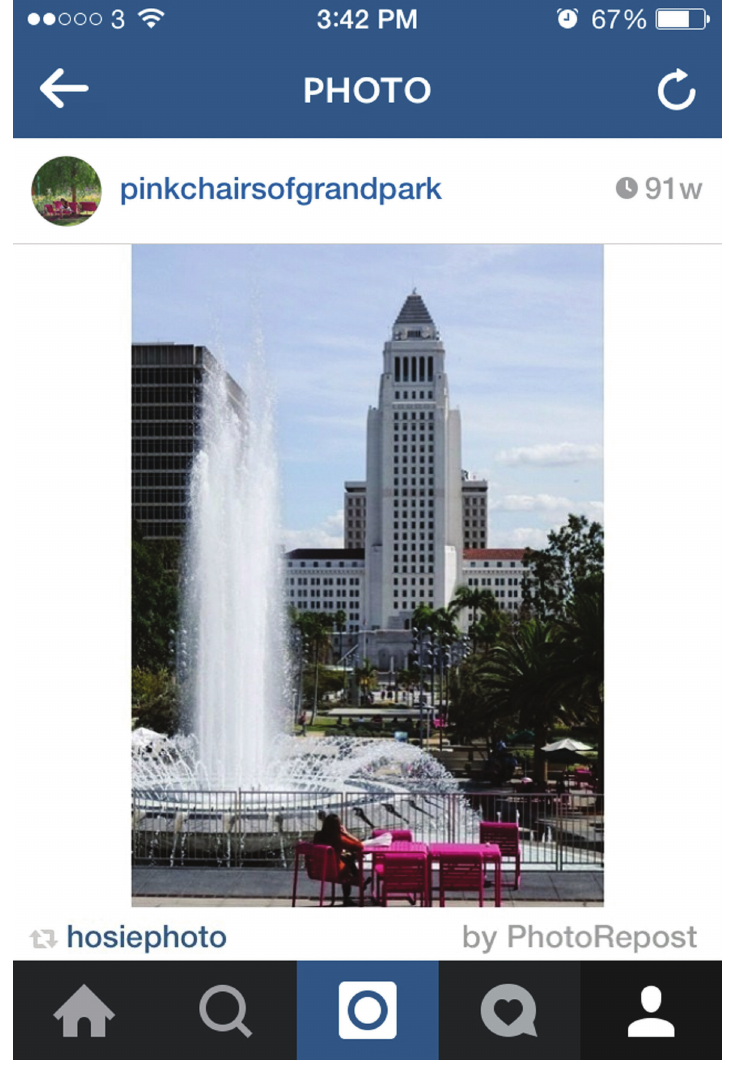
Figure 2: Screen shot of re-posted Instagram image, originally by